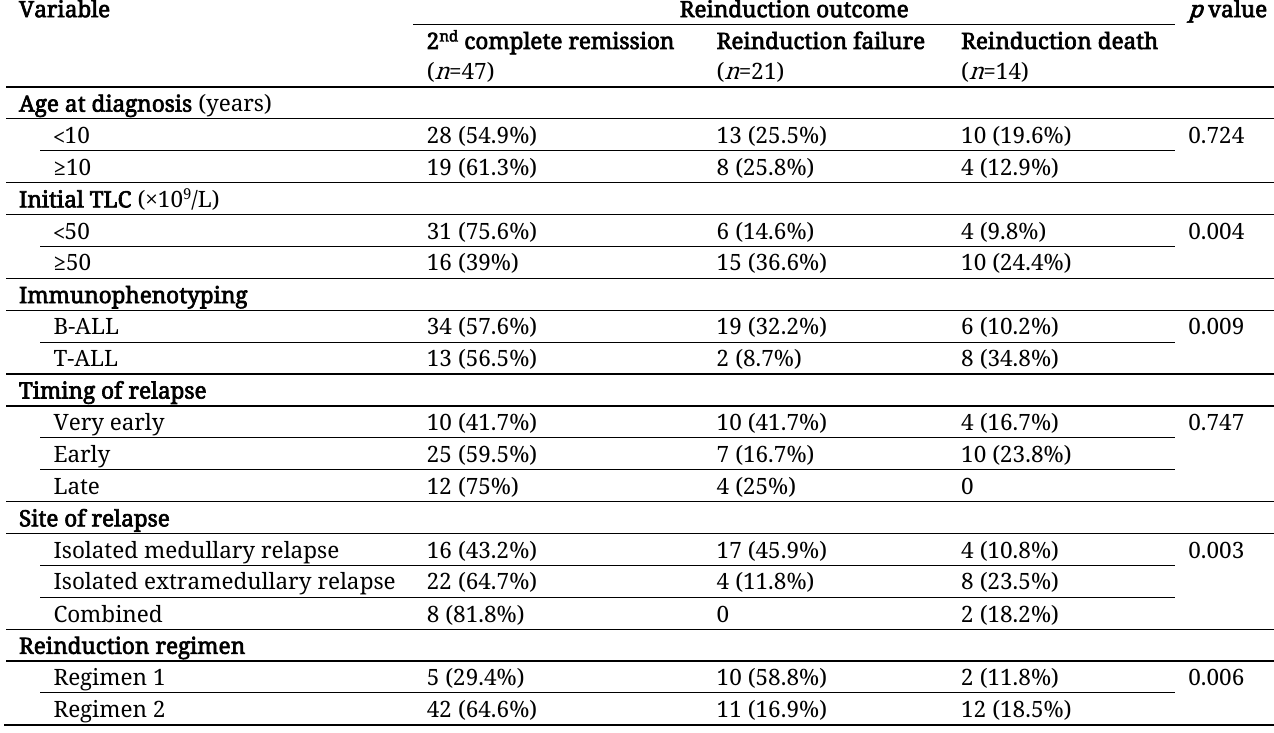
Figure 1: Flow diagram of management outcome of 82 children with first acute lymphoblastic leukemia relapse Table 2: The relationship between reinduction outcome and